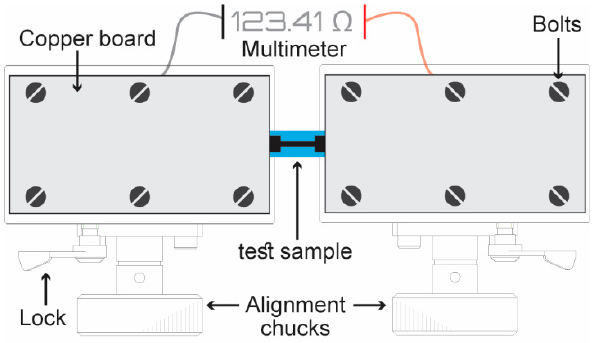
Figure 1. Stretch setup utilized which allows simultaneous resistivity measurements while the sample is put under strain.